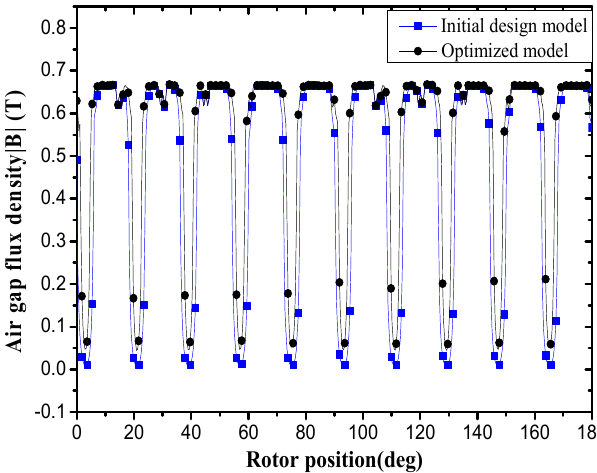
Figure 22. Air gap flux density.